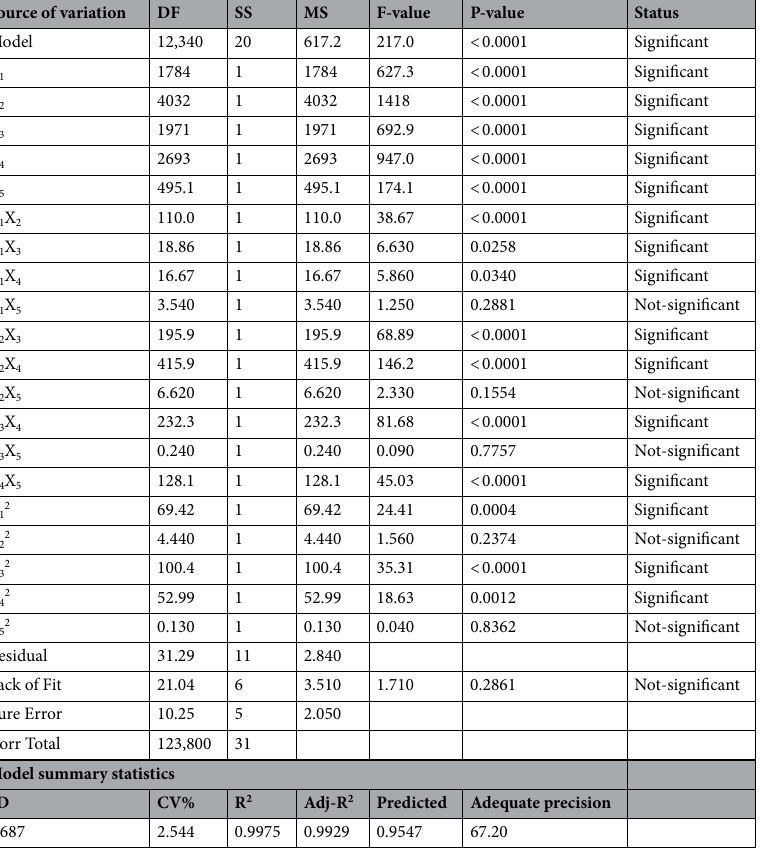
Table 2. ANOVA results for MG dye adsorption by meso-CaAl 2 O 4 . DF Degree of freedom, SS sum of squares, MS mean of